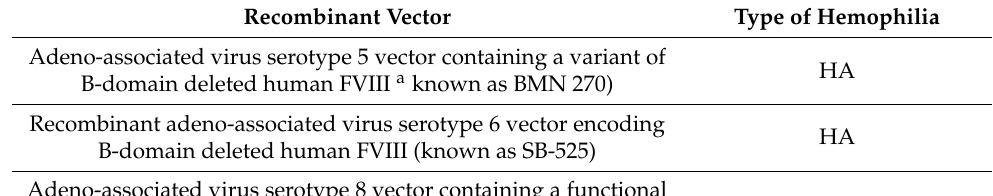
Table 1. Recombinant viral vectors used in the different clinical trials currently in progress on hemophilia A (HA) and hemophilia B (HB). Recombinant Vector Type of Hemophilia B-domain deleted human FVIII a known as BMN 270)